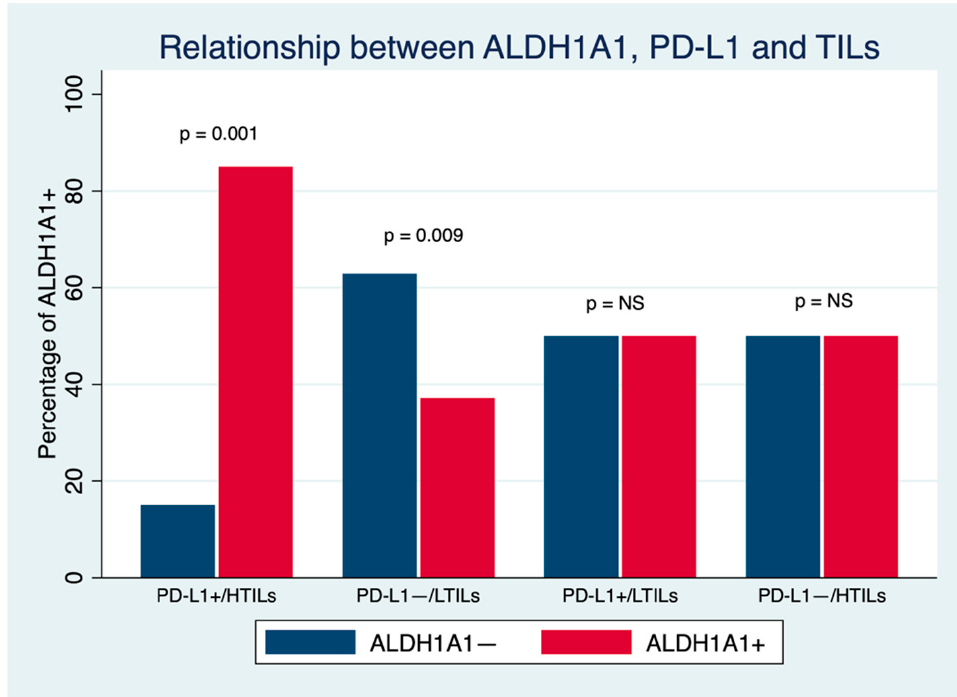
Figure 4. Relationship between ALDH1A1, PD-L1 and TILs in breast cancer. NS: Nonsignificant.